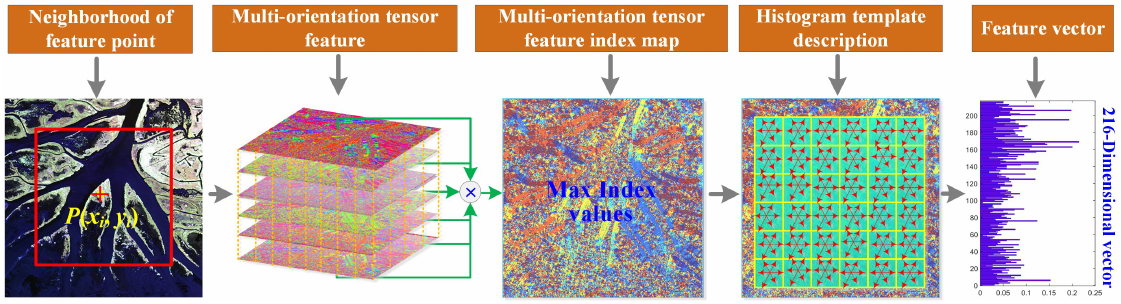
Figure 1 . Construction flowchart of the MoTIF